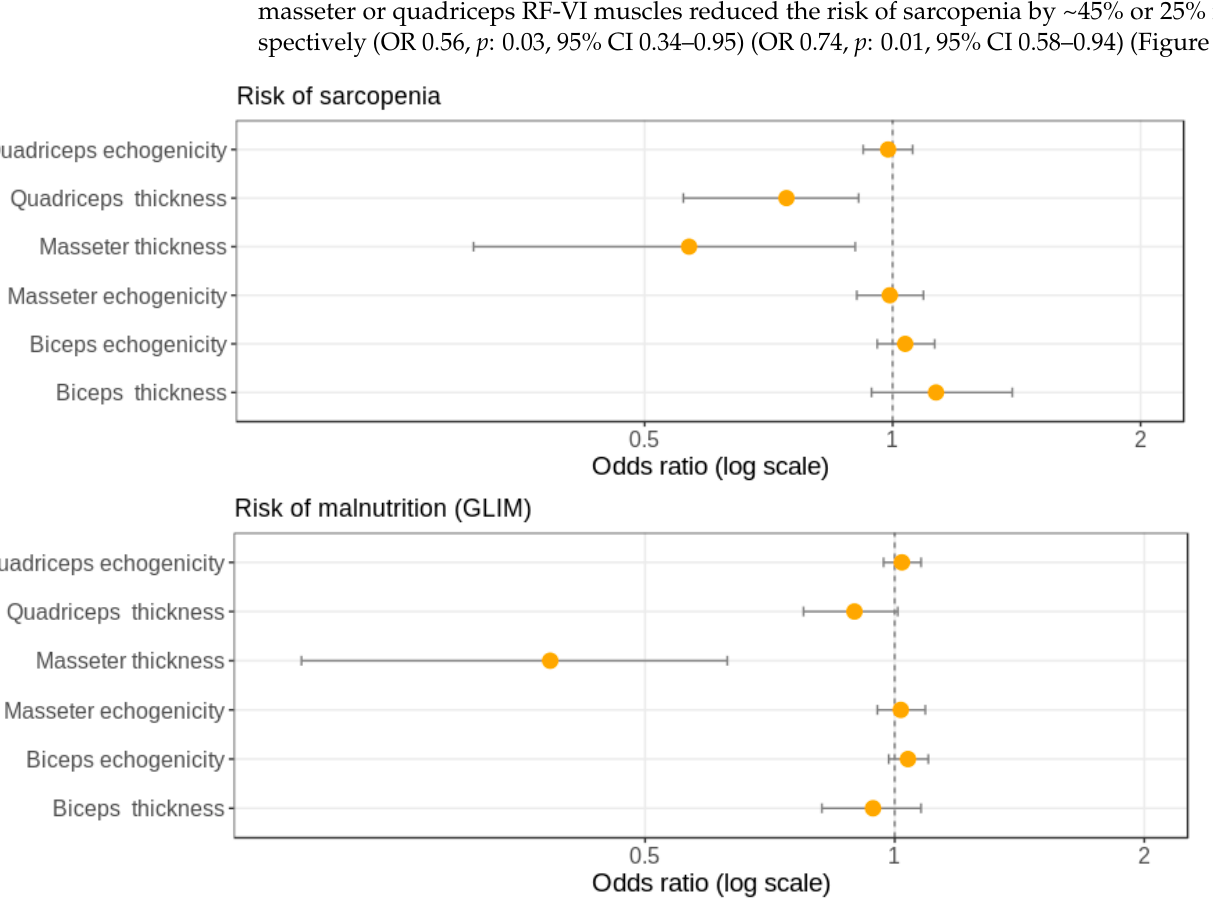
Figure 3. Forest plot of the multivariate adjusted model (logistic regression) of significant odd ratios for risk of sarcopenia and malnutrition with thickness and echogenicity of the three muscle groups studied by ultrasound.